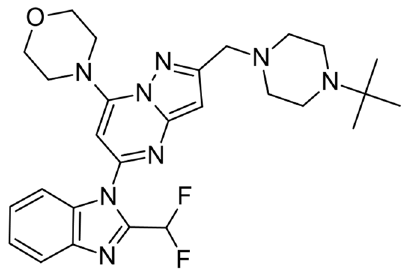
Figure 1. Structure of CPL302415.